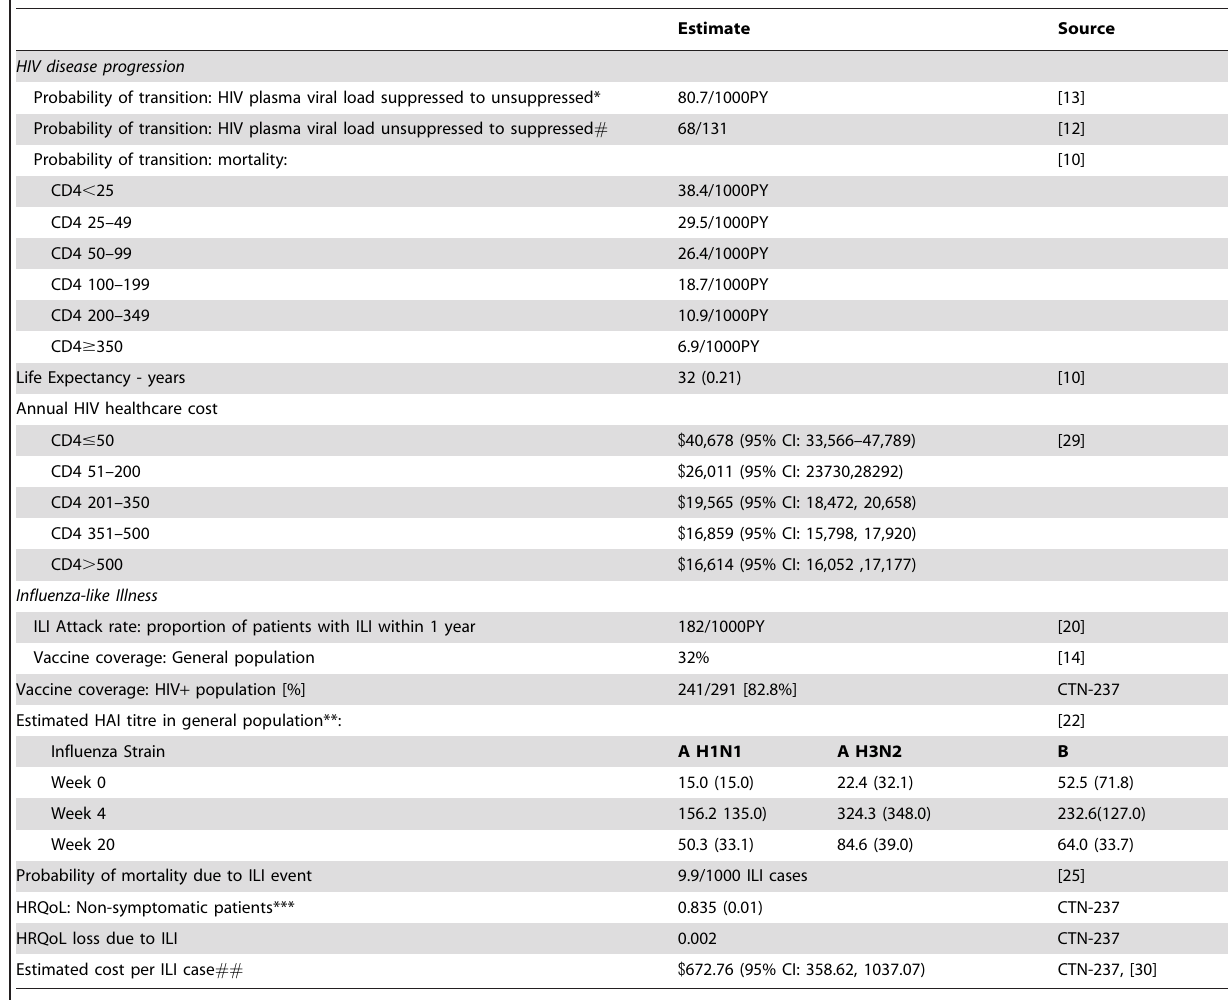
Table 1. Model parameters.